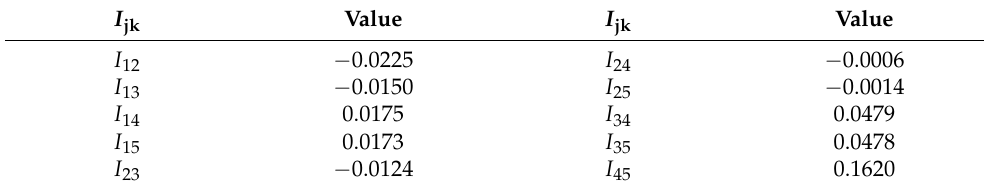
Table 8. Values for I jk .